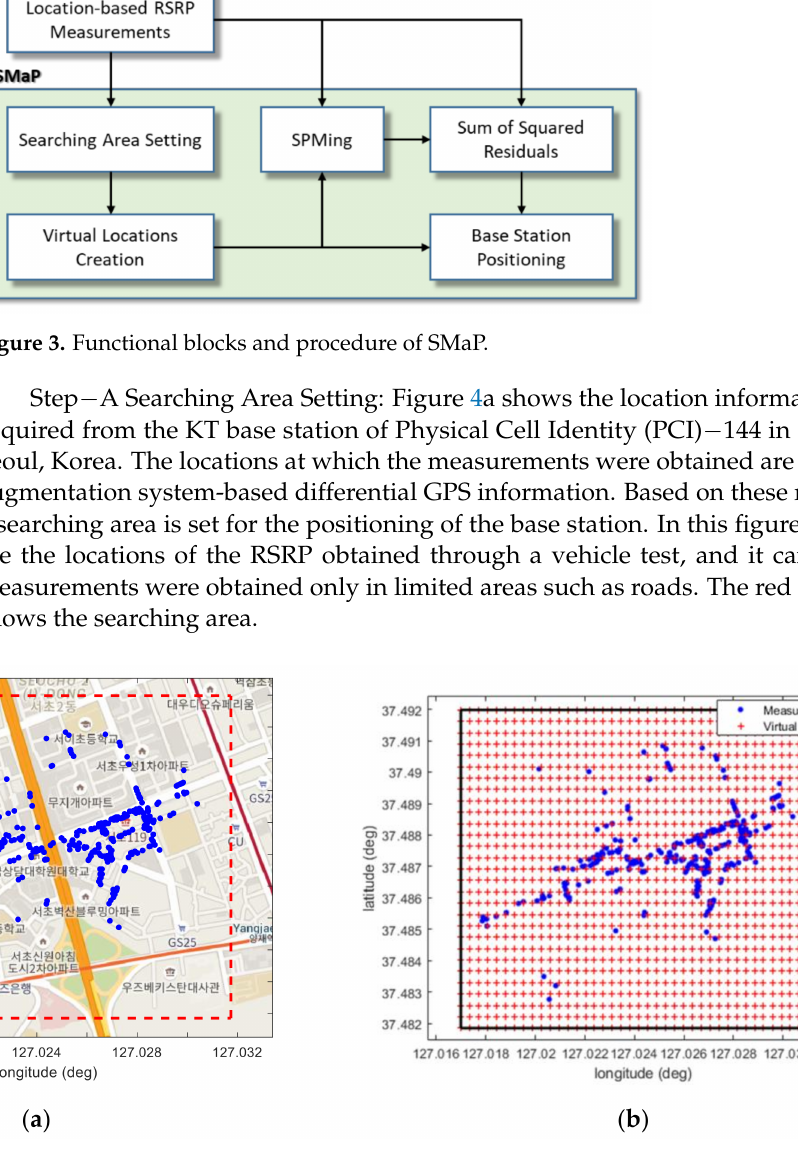
Figure 4. An example of RSRP measurements and VLs. ( a ) Locations of RSRP measurements and the searching area; ( b ) grid points for